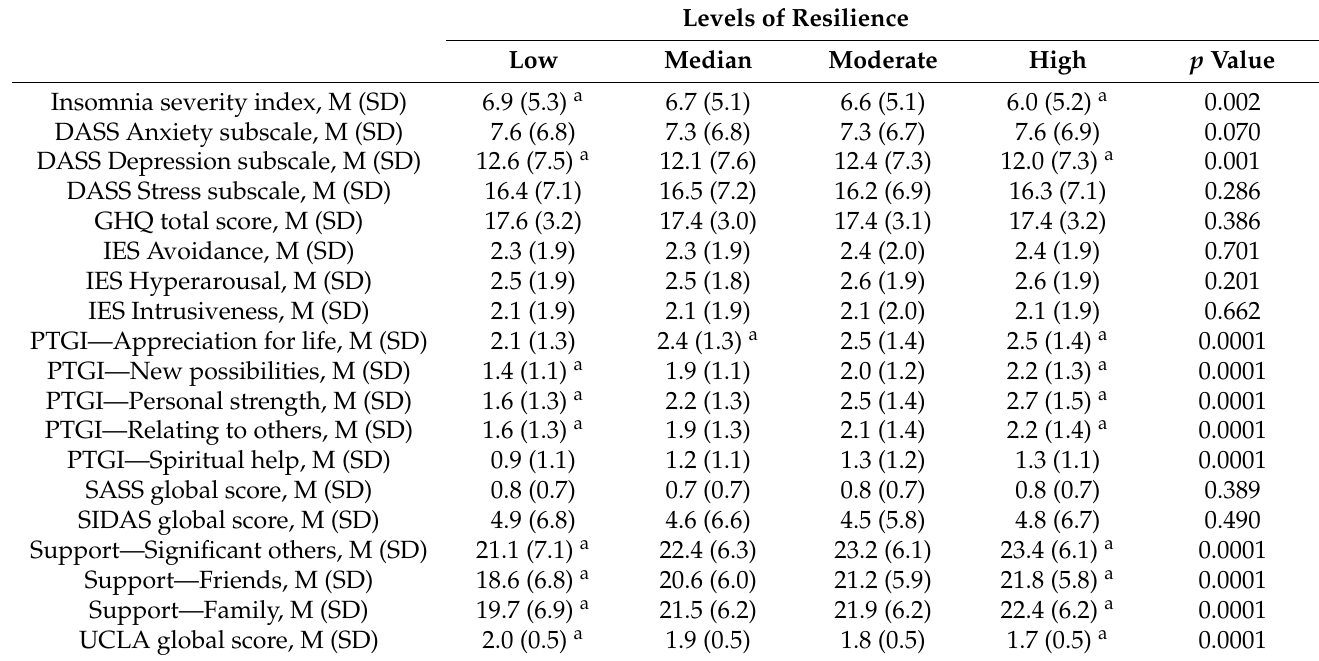
Table 3. Differences in clinical characteristics according to the levels of